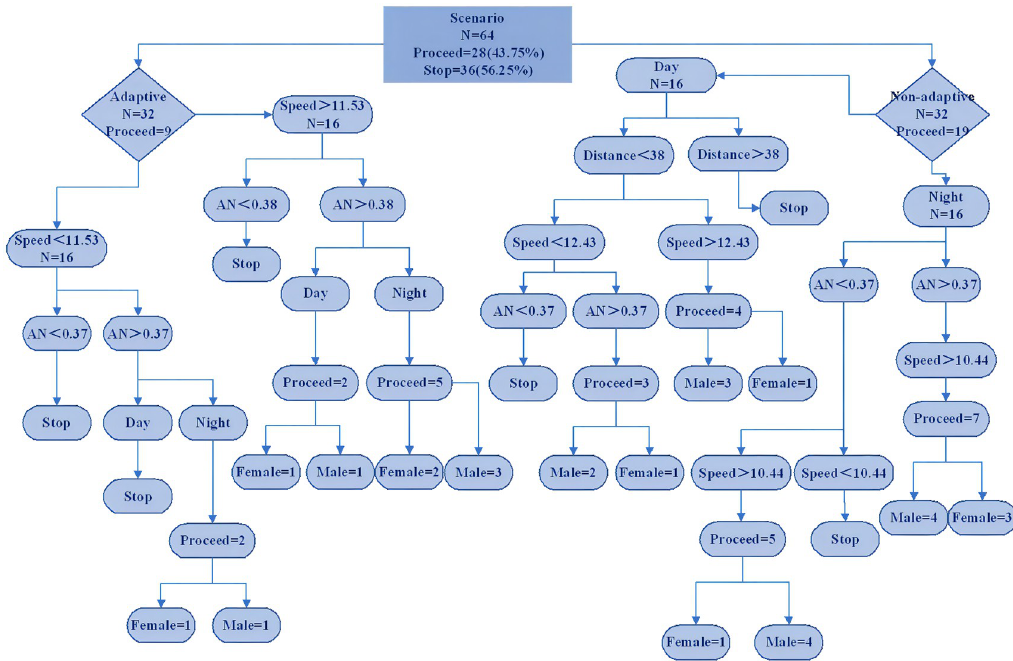
Fig 3. Decision trees. Schematic diagram of the decision tree for the stop/pass decision model. Note that the numbers in the circles denote interaction terms; distance, AN, and speed denote the distance to the stop line at the start of the yellow light, acceleration noise (m/s2),